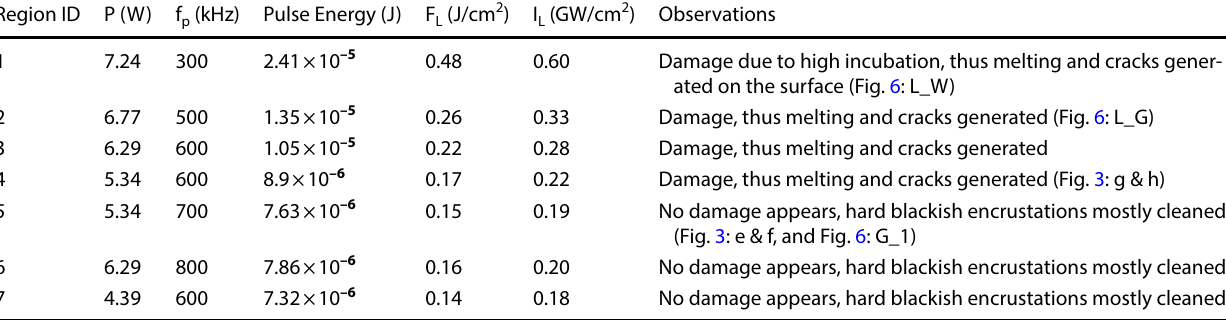
Table 2 Experimental parameters used for the initial assessment of the laser interaction with archaeological bone studied and reported here